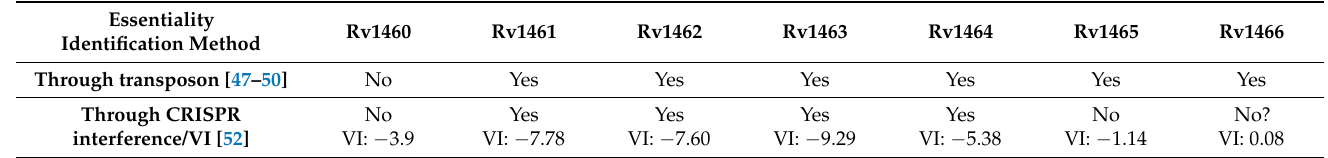
Table 2. Genes predicted to be implicated in Fe-S biogenesis in Mtb and their